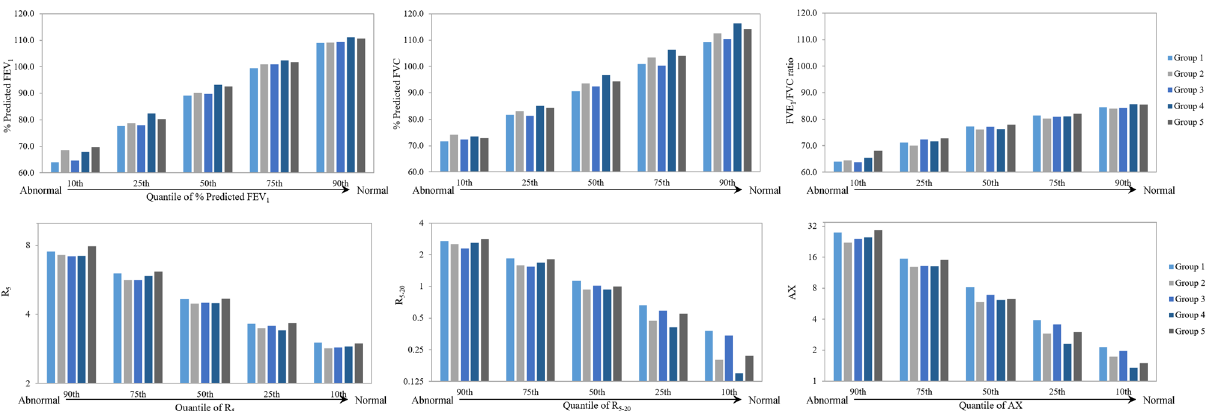
Figure 3. Quantiles of spirometry and oscillometry measures in five latent exposure groups. X-axis denotes five quantile levels, and y-axis is the quantile spirometry or oscillometry value within each